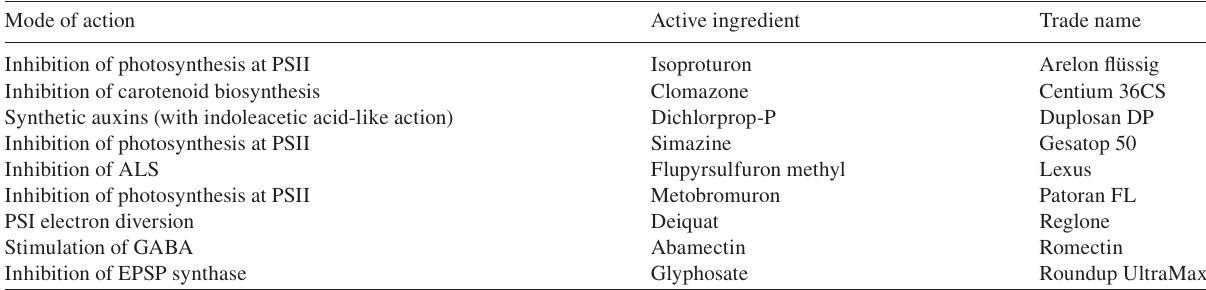
Table 3 Tested pesticides, their active ingredient, and their mode of action. Mode of action Active ingredient Trade name